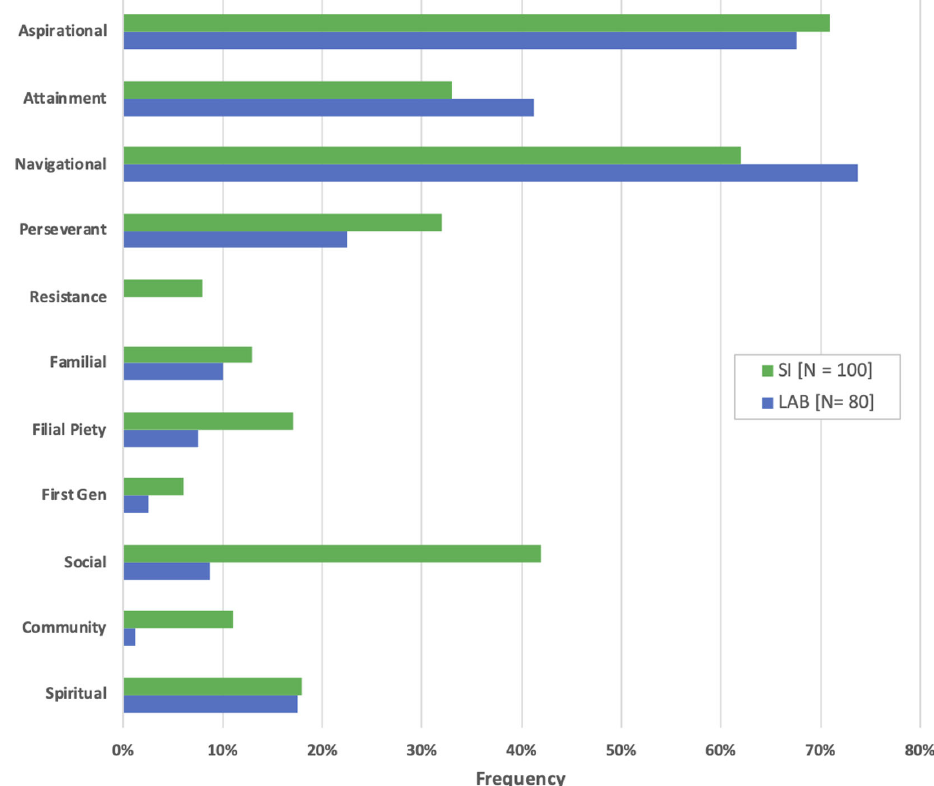
FIG. 1. Frequency of cultural capital themes expressed in the algebra-based physics I Supplemental Instruction physics courses (green) and Introductory Physics labs (blue). There are often multiple cultural capitals expressed in a given essay, so totals exceed